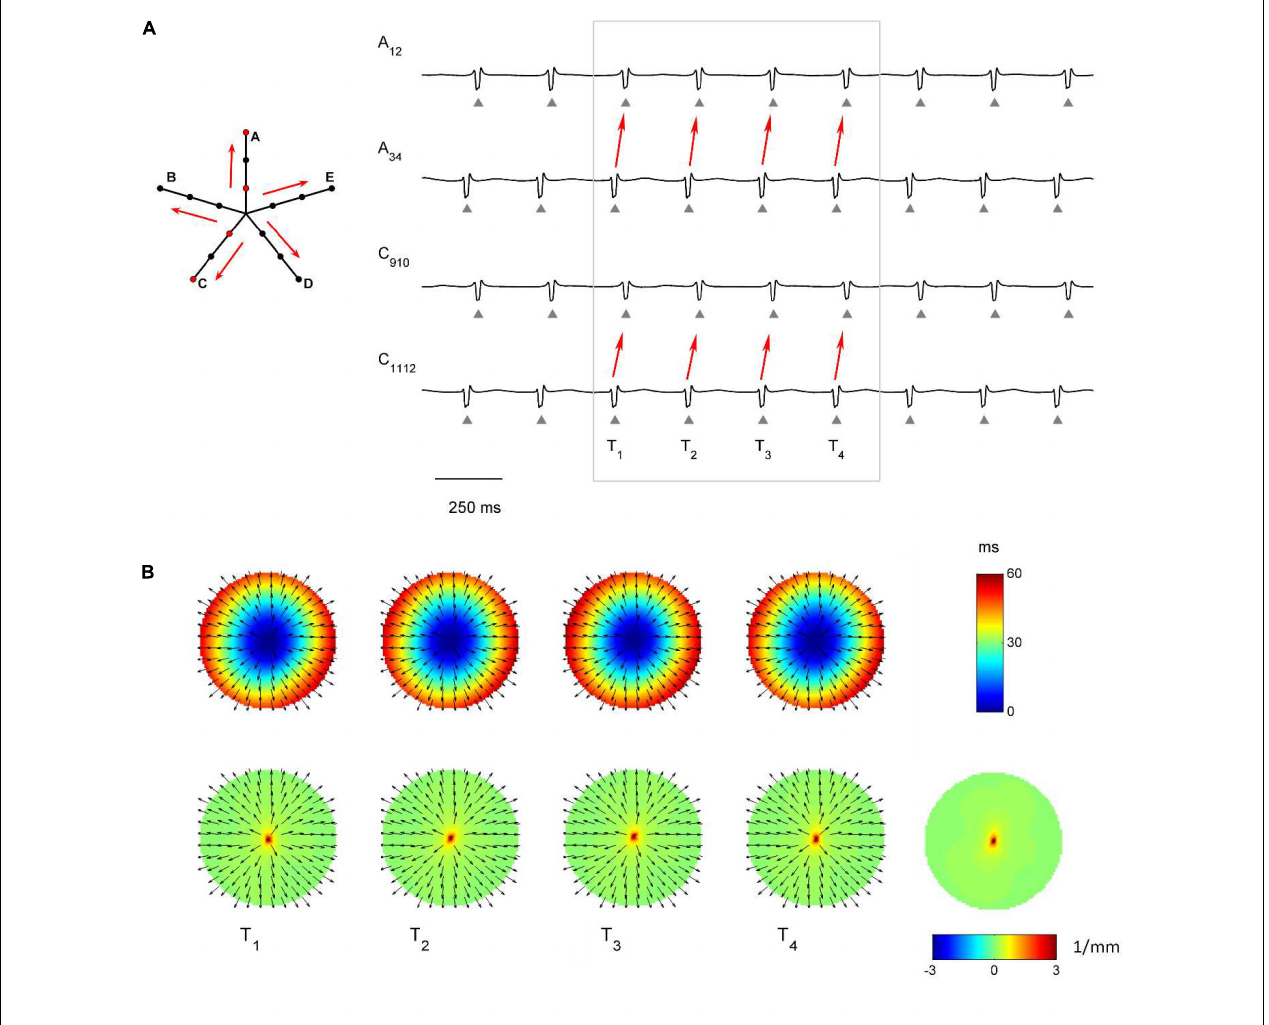
FIGURE 5 | Application of divergence analysis during simulated atrial fibrillation in a region activated by a focal driver. (A) Schematic representation of the multipolar mapping system, indicating the central position of the bipoles, and representative synthetic electrograms corresponding to the red bipoles of the catheter. Arrows indicate the prevalent activation sequence. (B) Beat-to-beat reconstructed activation (top) and divergence maps (bottom) corresponding to the evidenced beats. The average divergence map over the analyzed epoch is displayed in the bottom right panel. The presence of the focal driver is evidenced by maximal positive divergence values